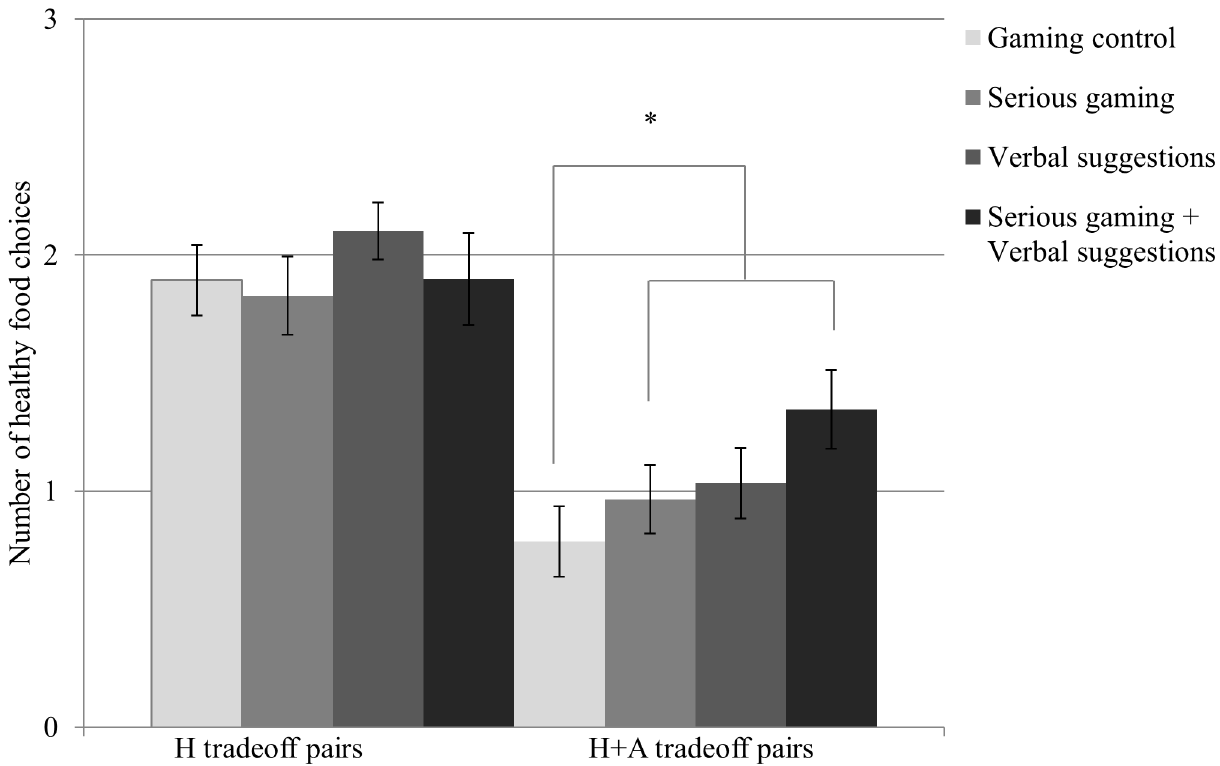
Fig 3. Means and standard errors of the mean for number of virtual healthy food choices. H tradeoff pairs = Healthiness tradeoff pairs; H+A tradeoff pairs = Healthiness and Attractiveness tradeoff pairs. A significant difference was found in that the two serious gaming conditions combined, i.e., with and without the verbal suggestion, showed a higher mean of healthy food choices on H+A tradeoff pairs compared to gaming control. No significant differences between the four conditions were found for H tradeoff pairs.